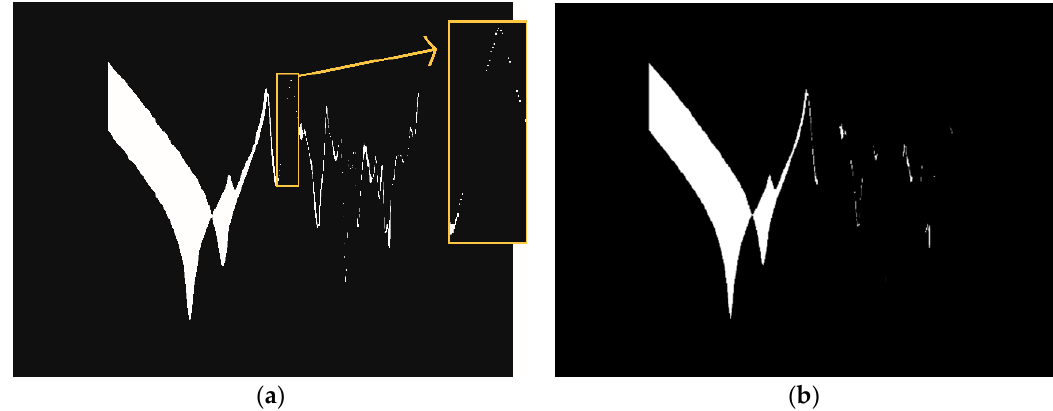
Figure 2. Examples of image binarization and erosion: ( a ) FRA image after binarization; and ( b ) FRA image after erosion.